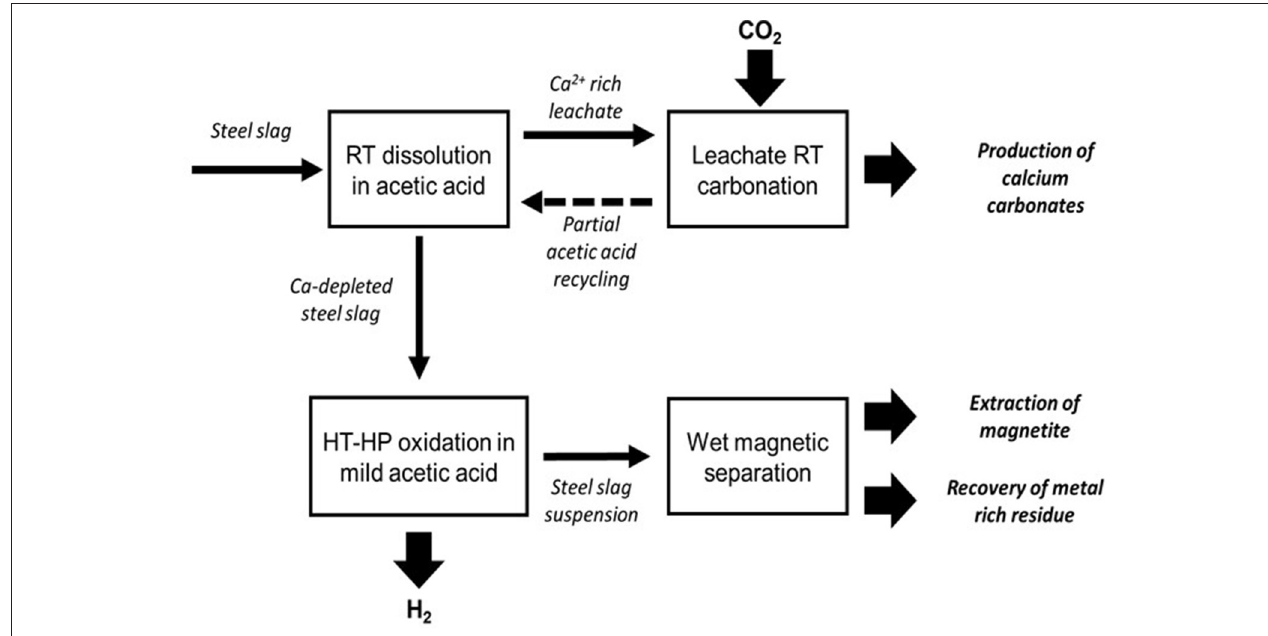
FIGURE 10 | Integrated steel slag valorization route including CO 2 mineral sequestration, PCC production, H 2 and magnetite (including nano-magnetite)